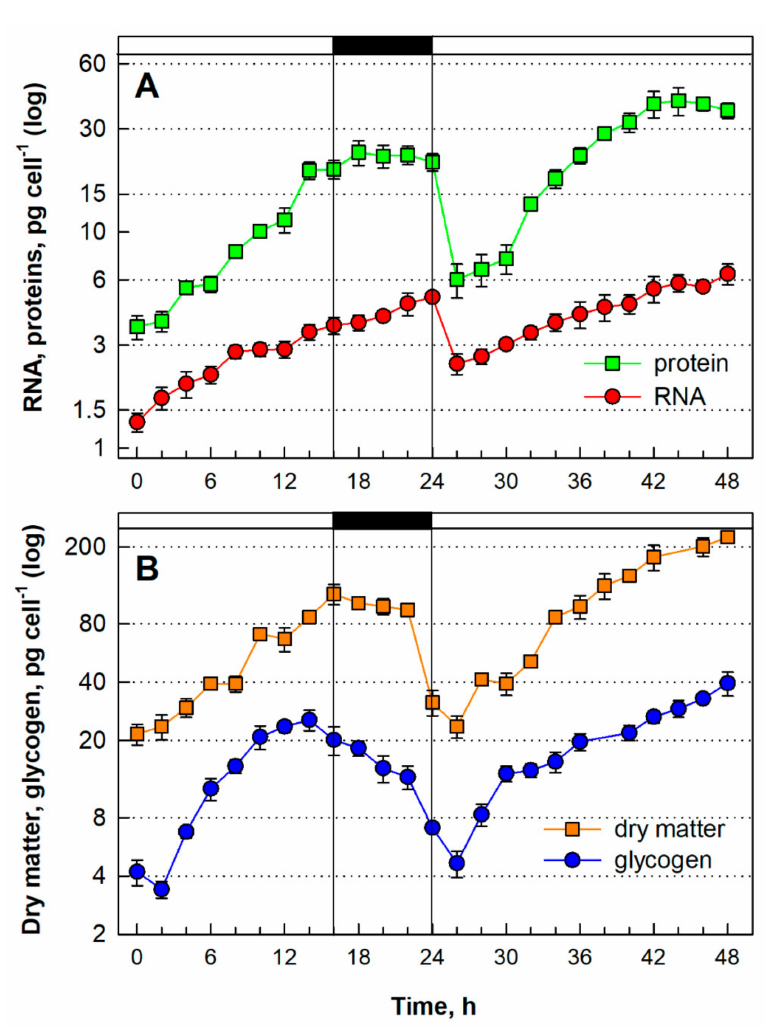
Figure 3. Synthesis of RNA and protein ( A ), concentration of dry matter and total glycogen ( B ) in a synchronous culture of Galdieria sulphuraria grown at 500 µ mol photons m − 2 s − 1 , 40 ◦ C, pH 3. Panel ( A ): Red circles-RNA synthesis, green squares-protein synthesis. Panel ( B ): Orange squares-dry matter, blue circles-glycogen. Note the logarithmic scale on the Y axis. Horizontal dashed lines indicate doublings of the initial values. The dark phase is indicated by the black bar. The data are plotted as means of biological triplicates. The error bars represent standard deviations ( ± SD) and are shown when larger than the symbol